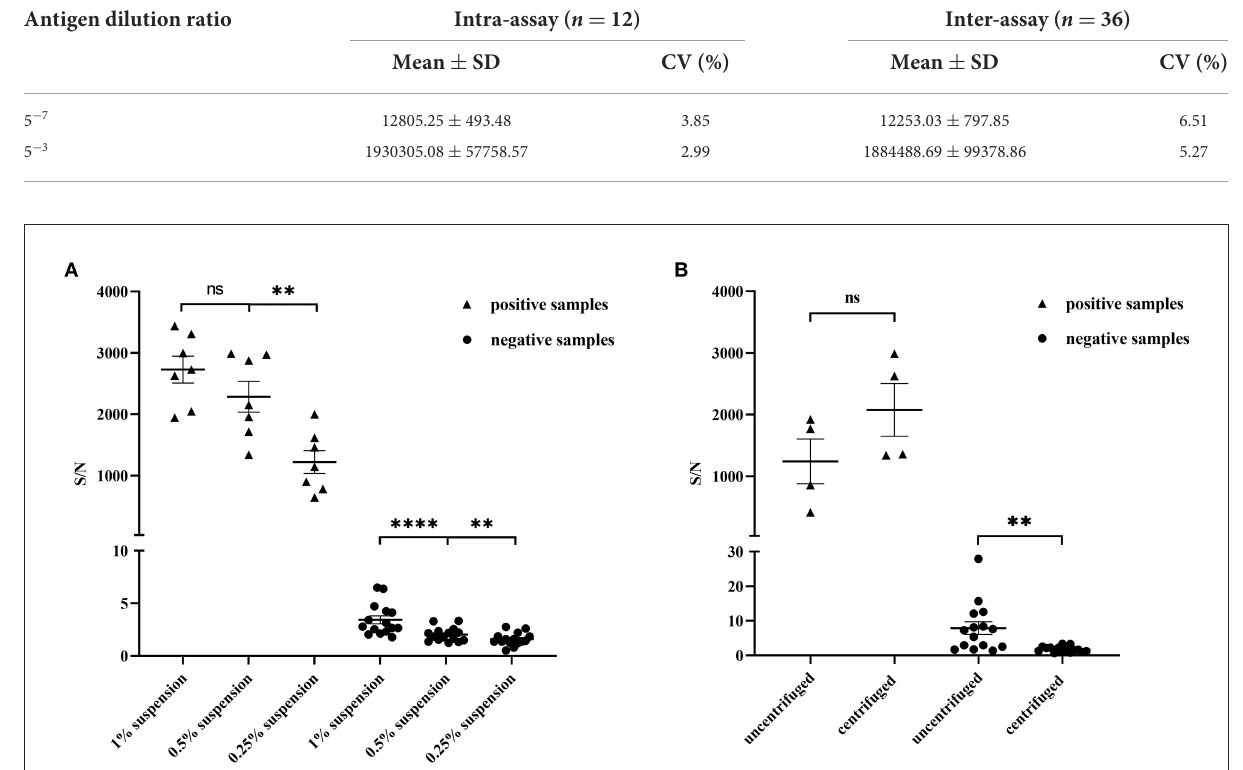
FIGURE3 Optimization of the stool sample pretreatment for AlphaLISA experiment. (A) Influence of 1% suspension, 0.5% suspension and 0.25% suspension on the test results of positive stool samples ( n = 7) and negative stool samples ( n = 15); (B) Influence of uncentrifuged and centrifuged for positive stool samples ( n = 4) and negative stool samples ( n = 15) on detection; ** P < 0.01; **** P < 0.0001; ns, not